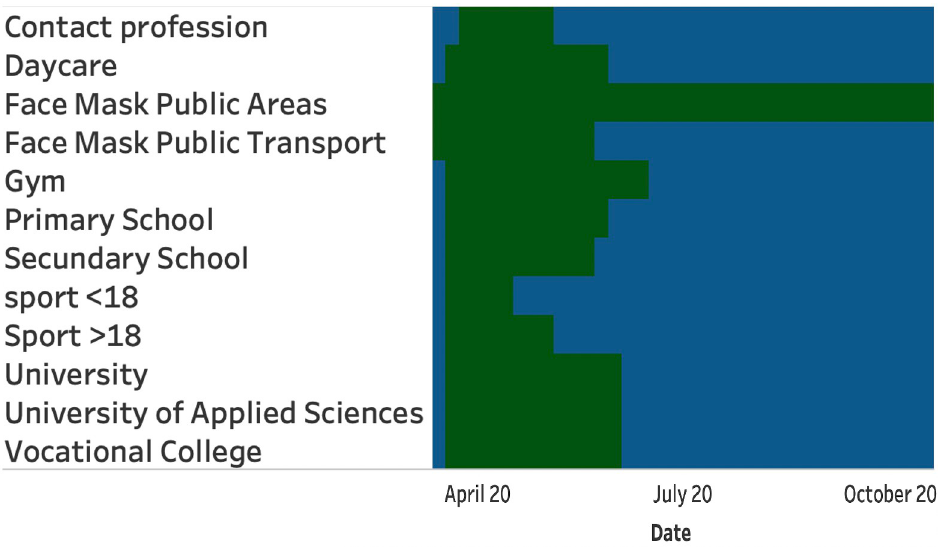
Fig 9. Opening and mandatory closure for different business segments. Opening (green), and mandatory closure (blue).